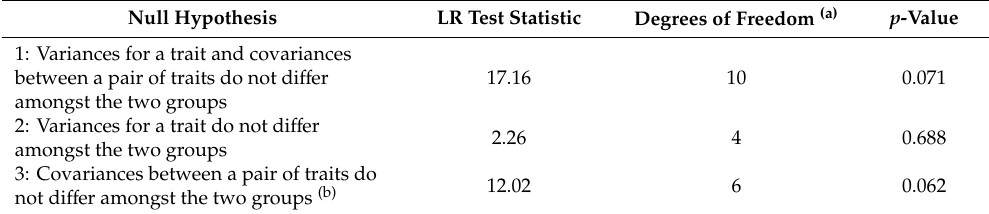
Table 4. Results from two-tailed likelihood-ratio (LR) tests that were applied to test whether estimates of additivegenetic(co)variancesdi ff eredsignificantlybetweentheadditivegenetic( G )variance-covariance matrices, estimated within the Mainland and Island population groups of E. globulus